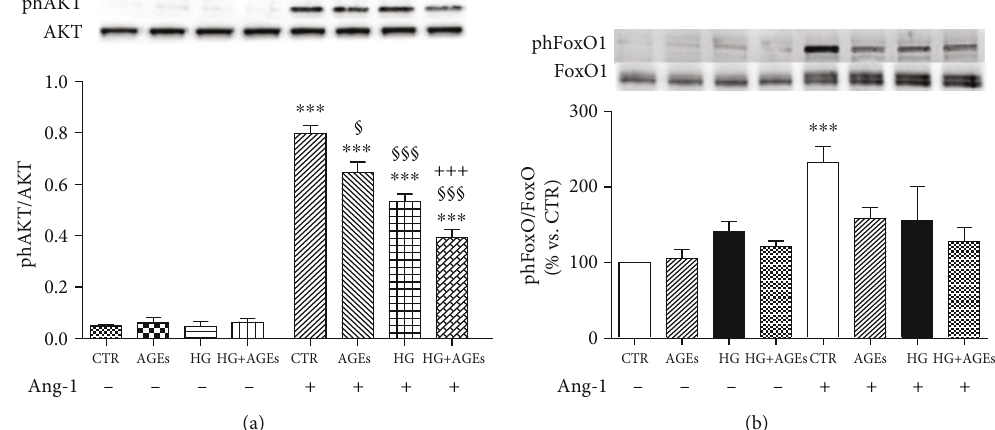
Figure 3: AGEs and HG reduced phosphorylation of AKT and FoxO1 induced by Ang-1. After the 5-day treatment described above, HMEC-1 cells were incubated for 2 hours in serum-free medium and, then exposed for 30 min to PBS (control) or Ang-1 (200ng/ml). Then, phAKT and AKT (a) and phFoxO1 and FoxO1 (b) were analyzed. Representative western blot analysis and quanti fi cation of densitometries of western blot band. Data were expressed as mean ± SEM of fold induction relative to unphosphorylated protein ( n = 4 ). ∗∗∗ p < 0 : 001 vs. the same culture condition in the absence of Ang-1; $ p < 0 : 5 and $$$ p < 0 : 001 vs. CTR+Ang-1; and +++ p < 0 : 001 HG+AGEs+Ang-1 vs. HG+Ang-1.